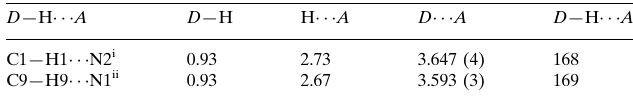
Hydrogen-bond geometry (A˚ , (cid:2)